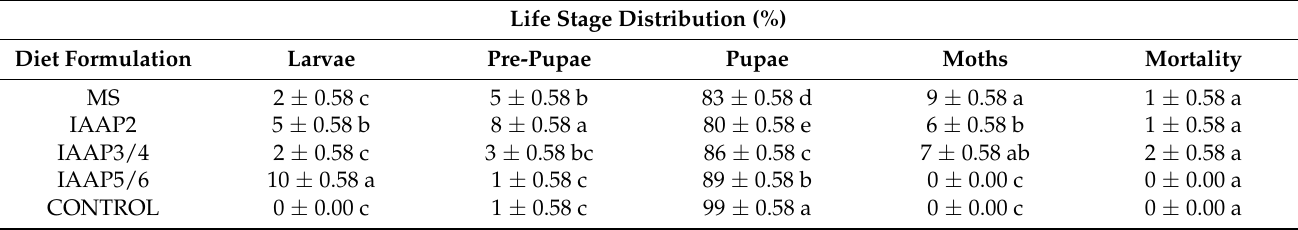
Table 5. Mean ( ± SE) distribution of Eldana saccharina life stages (percentage of larvae, pre-pupae, pupae, moths and mortality) [ n = 170] recorded at the time of full pupal harvest (day 27) on the MS, IAAP2, IAAP3/4, IAAP5/6 and control diets. Means within columns with different lower-case letters indicate significant differences ( p < 0.05). Life Stage Distribution (%) Pupae Moths